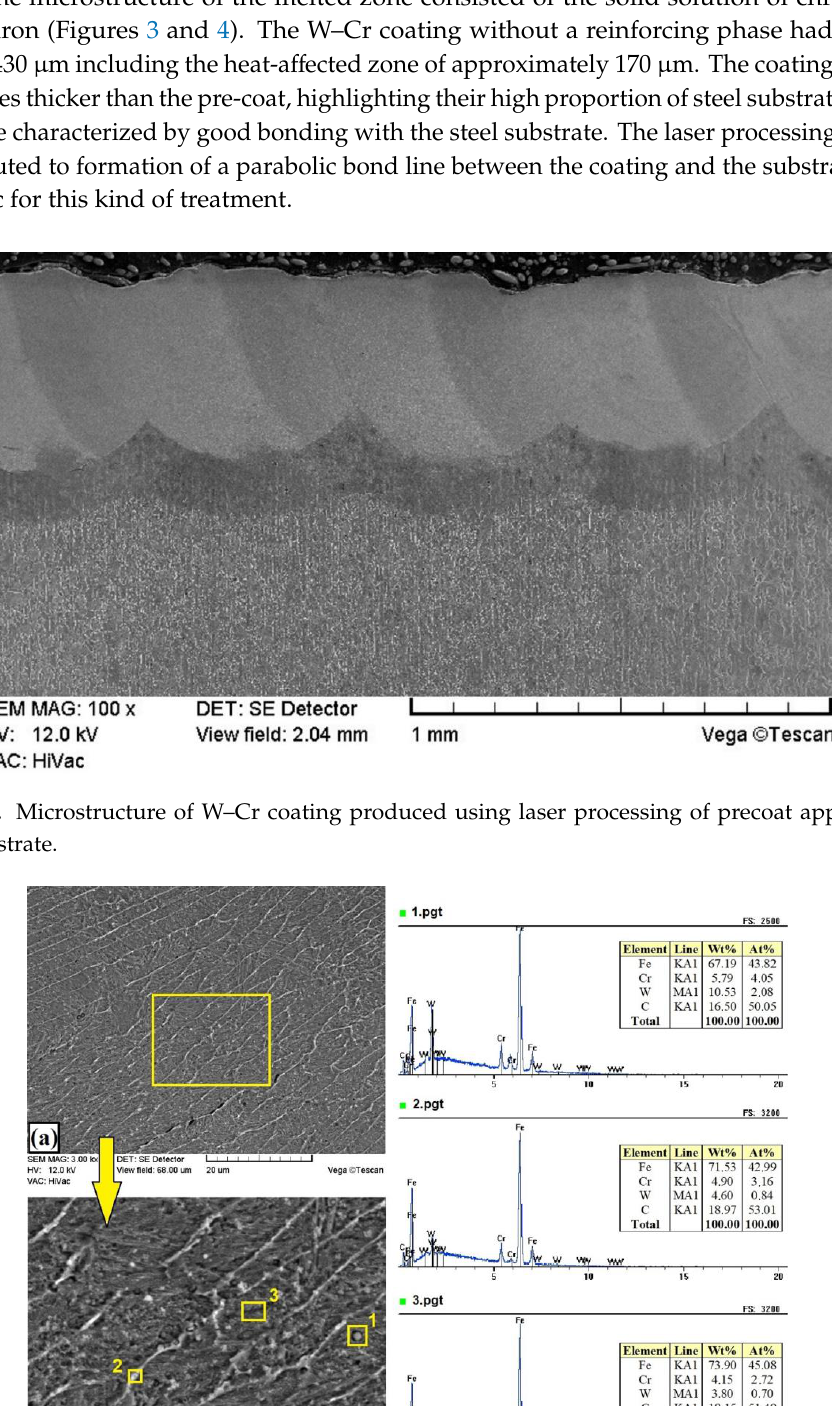
Figure 4. Microstructure and the energy-dispersive spectrometry (EDS) point analysis of W–Cr coating produced using laser processing of precoat applied on steel substrate: ( a ) melted zone; ( b ) magnification of melted zone .